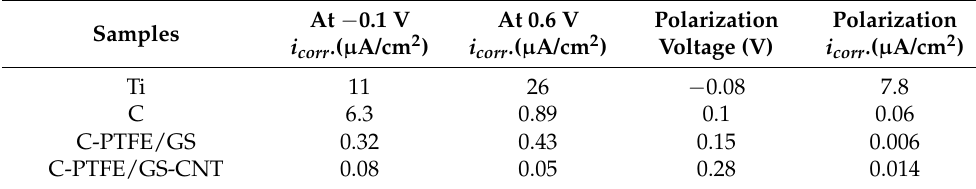
Figure 5. Potentiodynamic polarization curves of bare Ti, carbon film-coated Ti, C-PTFE/GO film-coated Ti and C-PTFE/GO-CNT film-coated Ti 70 ◦ C, 0.5 M H 2 SO 4 , 2 ppm HF, air bubbling) conditions. Table 2. Comparison of the corrosion current density under − 0.1 V, 0.6 V and Polarization current and voltage.